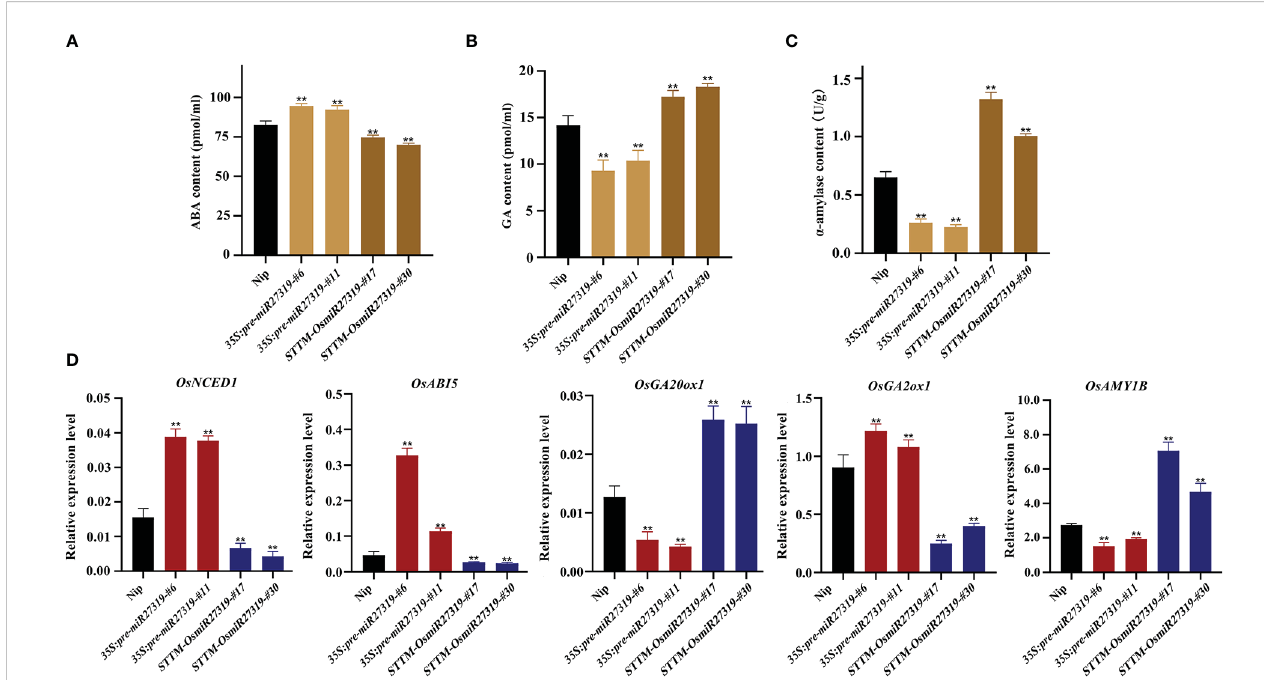
FIGURE 6 Regulatory pathways of miR27319 in rice seed dormancy. (A) ABA contents in Nip, 35S:pre-miR27319 , and STTM-OsmiR27319 . Signi fi cant differences were determined using Student ’ s t-test: ** P < 0.01. (B) GA contents in Nip, 35S:pre-miR27319 , and STTM-OsmiR27319 . Signi fi cant differences were determined using Student ’ s t-test: ** P < 0.01. (C) Alpha-amylase activities in Nip, 35S:pre-miR27319 , and STTM-OsmiR27319 . Signi fi cant differences were determined using Student ’ s t-test: ** P < 0.01. (D) Relative expression levels of the key genes involved in ABA and GA biosynthesis, catabolism, and signaling pathways. Gene ID: Os03g0645900 ( OsNCED1 ), Os01g0859300 ( OsABI5 ), Os03g0856700 ( OsGA20ox1 ), Os05g0158600 ( OsGA2ox1 ), and Os01g0357400 ( OsAmy1B ). Signi fi cant differences were determined using Student ’ s t-test: ** P <